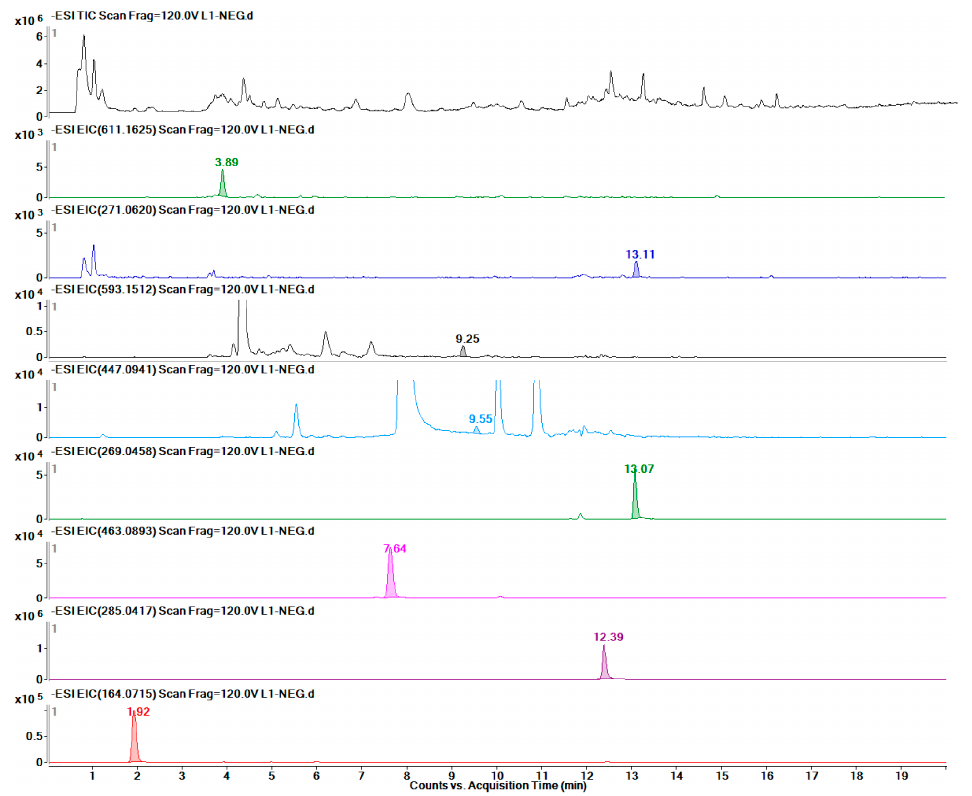
Figure 12. TIC of the L part and EICs of each of the eight metabolites.